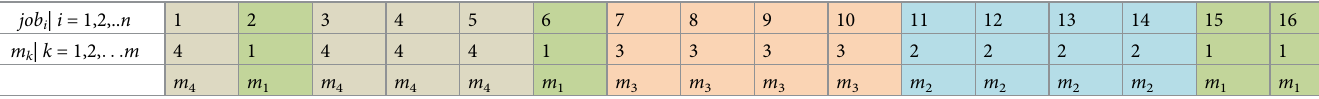
Table 1. Illustration of machine assignment vector. job i | i = 1,2,.. n m k | k = 1,2, ...